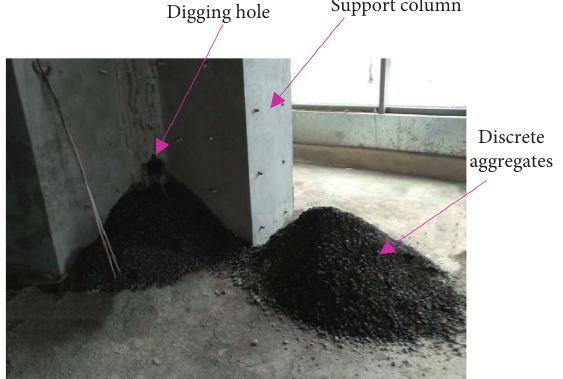
Figure 5: Flushing and digging out the concrete inside the damaged steel pipe.